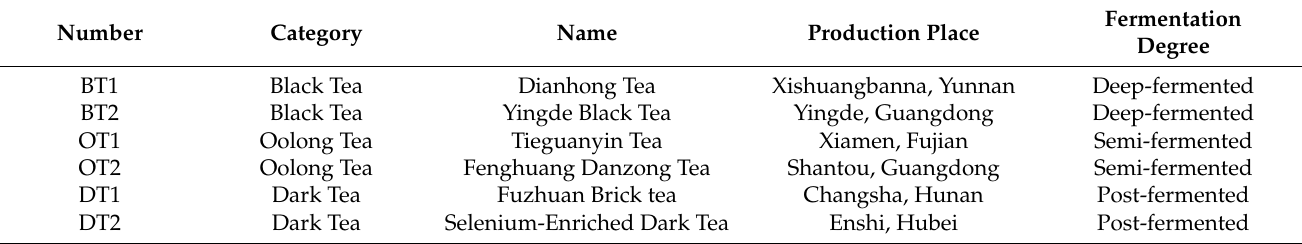
Table 1. The specific information of six selected